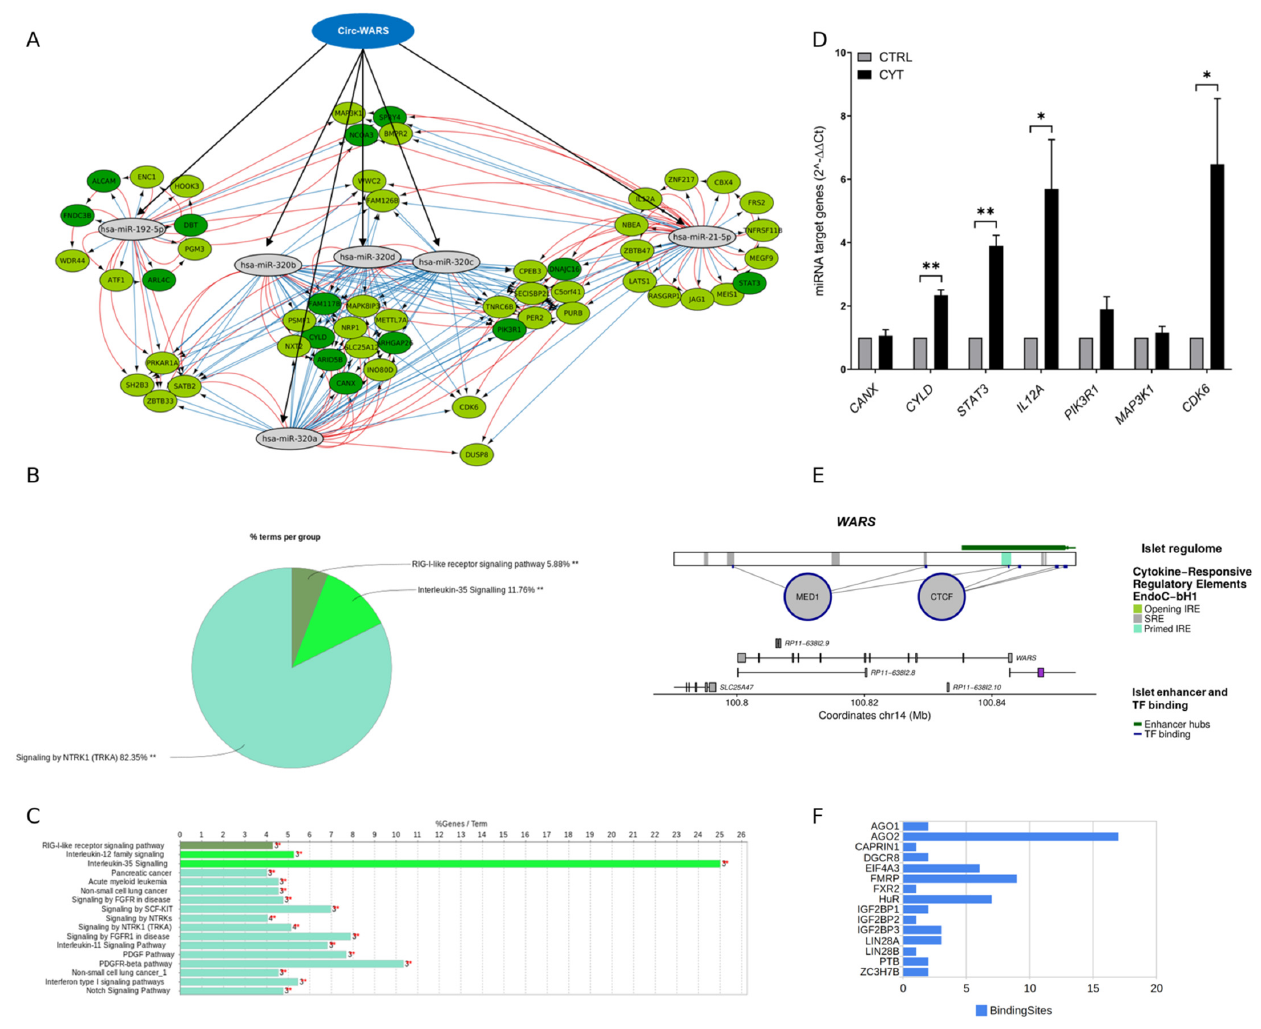
Figure 6. circWARS–miRNA–mRNA interaction network. ( A ) The figure shows the circWARS– miRNA–mRNA network for β -cell-enriched miRNAs (shown as grey nodes): the hsa-miR-192-5p, hsa-miR-21-5p, and hsa-miR-320 family are predicted to bind circWARS. The target genes for the miRNAs were selected based on Targetscan (red edges) and MirTarBase (blue edges). Only those targets that were upregulated by pro-inflammatory cytokines either at the mRNA level (light green nodes) or both the mRNA and protein levels (dark green nodes) in EndoC- β H1 cells are shown; ( B ) Pathway-based enrichment analysis of 54 upregulated target genes of β -cell-enriched miRNAs (hsa-miR-192-5p, hsa-miR-21-5p, and hsa-miR-320 family) with potential binding sites for circWARS revealed three clusters of enriched pathways; ( C ) The individual enriched pathway terms are shown as a bar plot and are clustered into three groups based on color; ( D ) The expression of hsa-miR-192- 5p, hsa-miR-21-5p, and the hsa-miR-320 family target genes, CANX , CYLD , STAT3 , IL12A , PIK3R1 , MAP3K1, and CDK6 is shown at mRNA level in the EndoC- β H1 cells that were untreated (CTRL) or treated with IL-1 β and IFN- γ (CYT) for 48 h ( n = 3). The normalized expression values are presented as 2^ −ΔΔ Ct. GAPDH was used as a housekeeping gene. * p < 0.05, ** p < 0.01. ( E ) Promoter regions of WARS locus harbor islet enhancer hub, islet TF binding sites, and primed cytokine-responsive elements; ( F ) RNA-binding protein (RBP) sites predicted for circWARS.